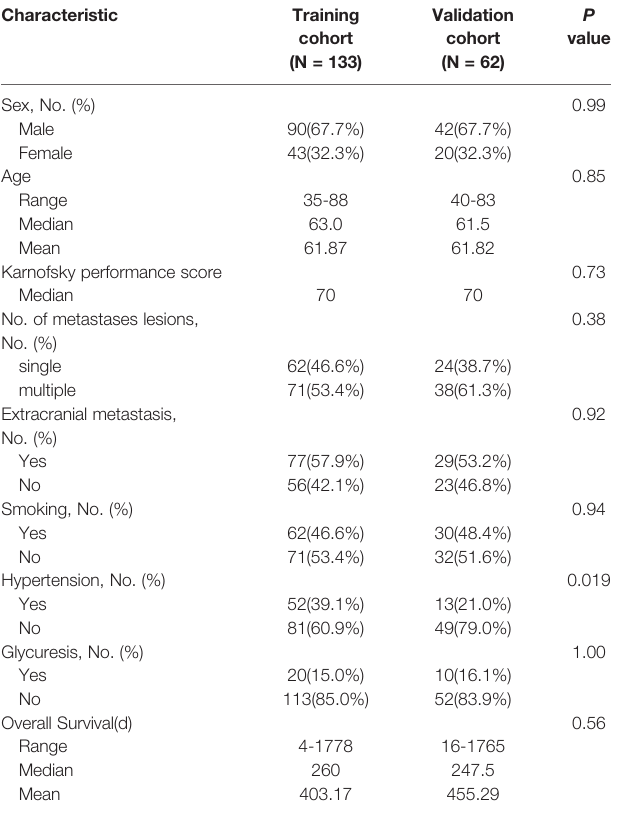
TABLE 1 | Characteristics of patients in the training and validation cohorts.